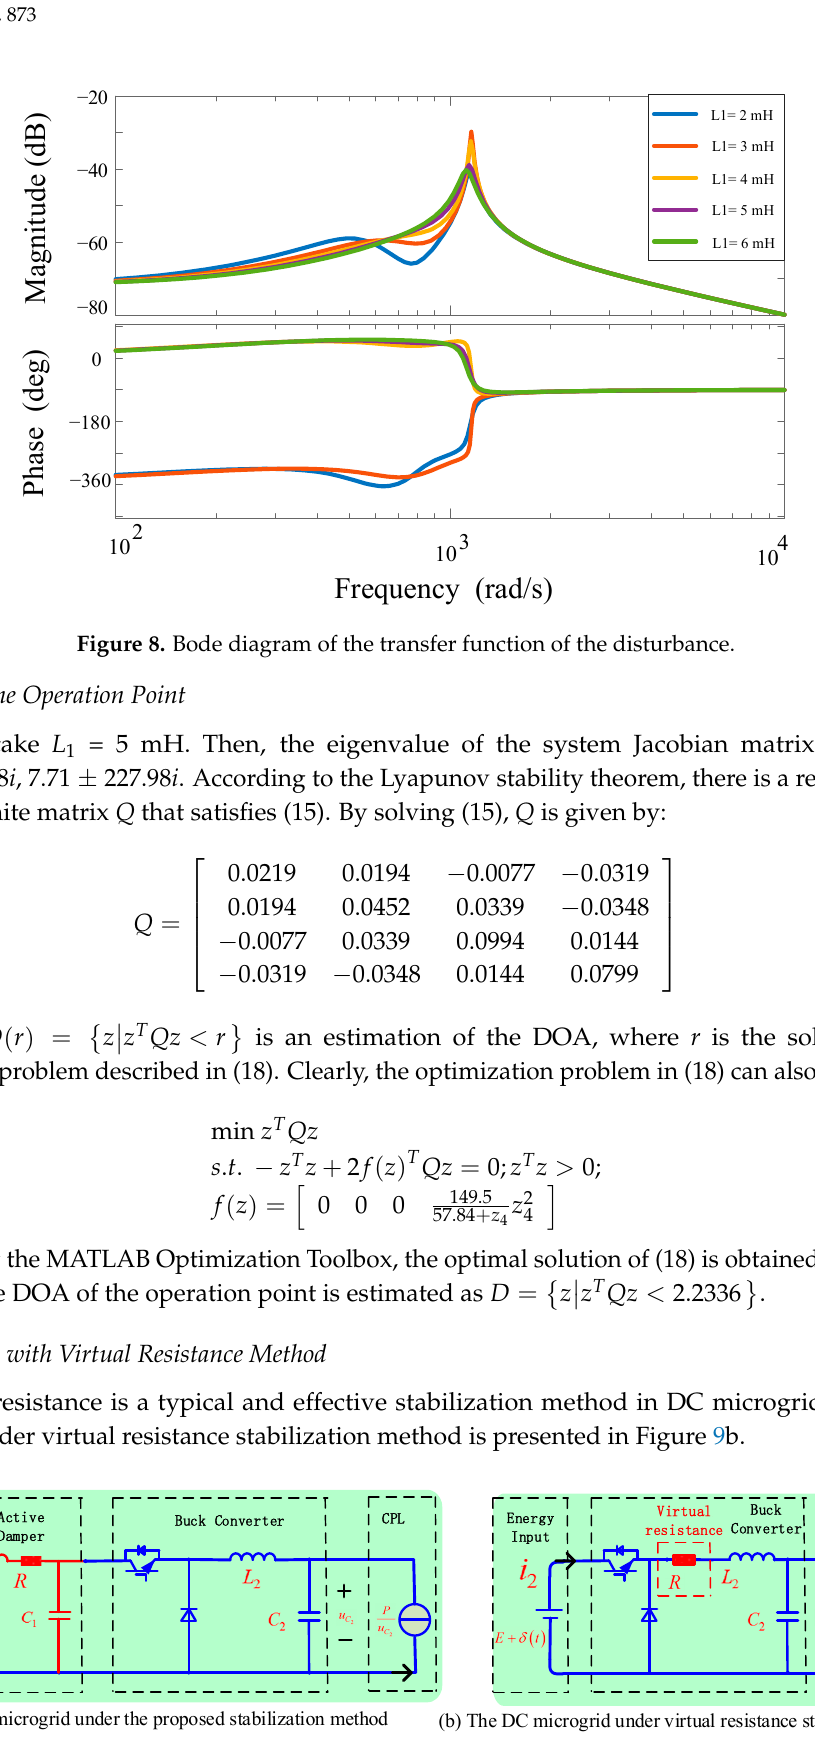
Figure 9. The topologies of the DC microgrid under two different stabilization methods.